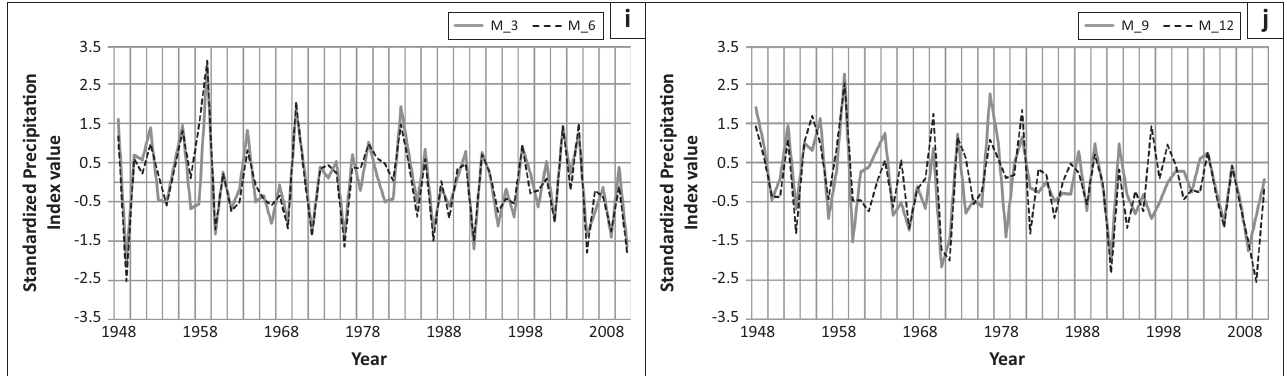
FIGURE 2 (Continues…): Drought in (a) Rangpur, (c) Dinajpur, (e) Bogra, (g) Ishurdhi and (i) Rajshahi based on 3-month SPI (M_3) and 6-month SPI (M_6). Drought in (b) Rangpur, (d) Dinajpur, (f) Bogra, (h) Ishurdhi and (j) Rajshahi based on 9-month SPI (M_9) and 12-month (annual) SPI